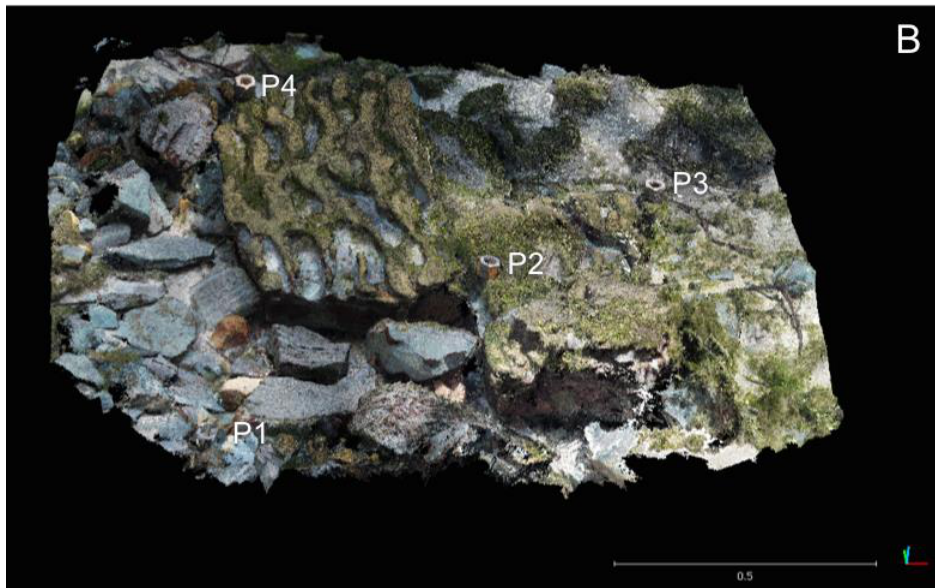
Figure A1. ( A ) Photograph of underwater rock structure used to determine the uncertainty in the dense 3D point cloud. P1 – P4 represent the locknuts used as targets. ( B ) Dense 3D point cloud of the rock structure in ‘a.’ Scale bar is in meters. The interactive point cloud is available at: https://bit.ly/calib_rock.